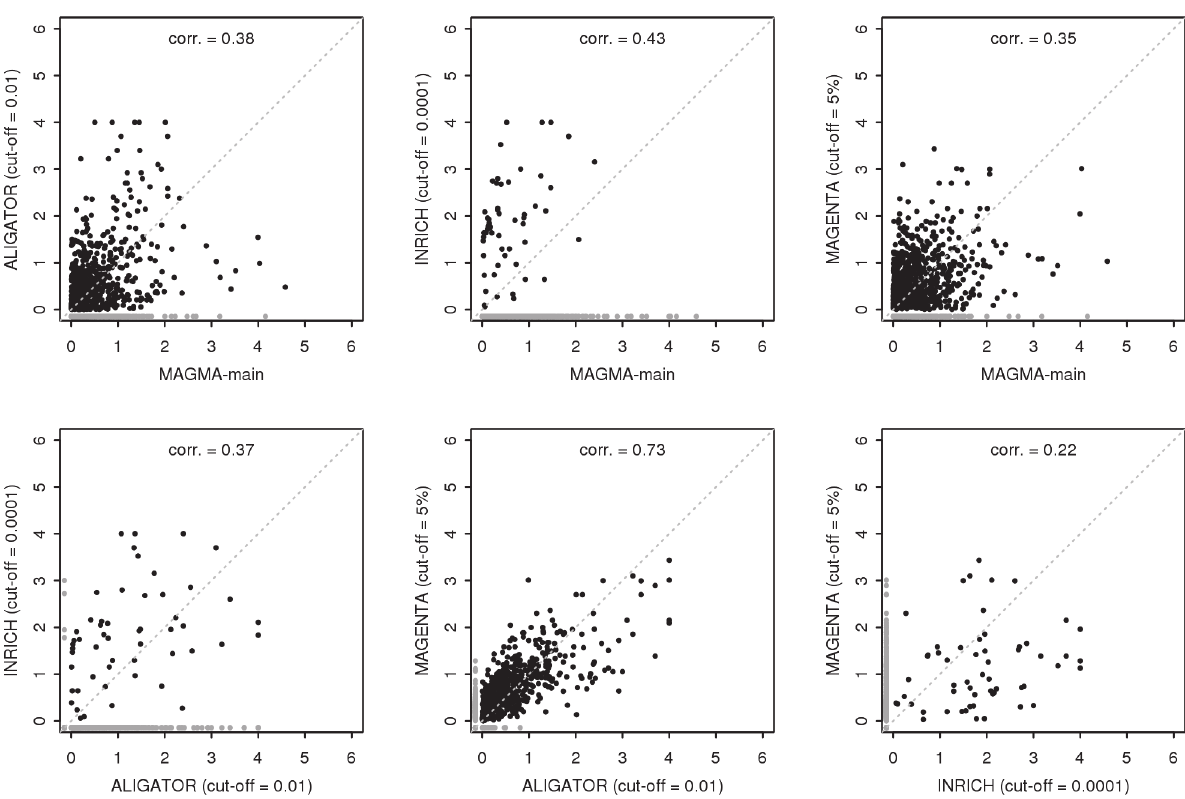
Fig 3. Comparison of competitive gene-set analysis results. Gene set − log10 p-values from the CD data competitive gene-set analysis for MAGMA, ALIGATOR, INRICH and MAGENTA. Results for ALIGATOR and INRICH are shown for each for the SNP p-value cutoff that yielded the highest observed power (0.01 and 0.0001 respectively), MAGENTA at the advised 5 th percentile cutoff. P-values for gene sets not evaluated by one of the methods are shown in grey. The shown correlations are for the − log10 p-values for gene-sets evaluated by both methods.